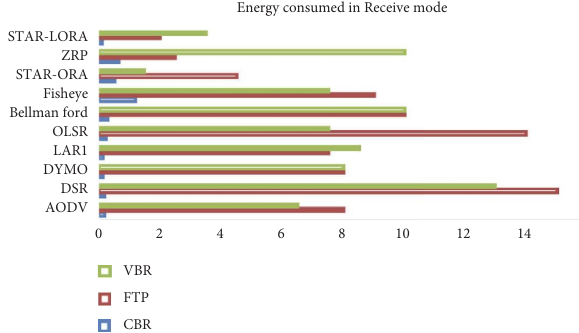
Figure 15: Receive mode energy consumption of all routing protocols for 120 nodes.